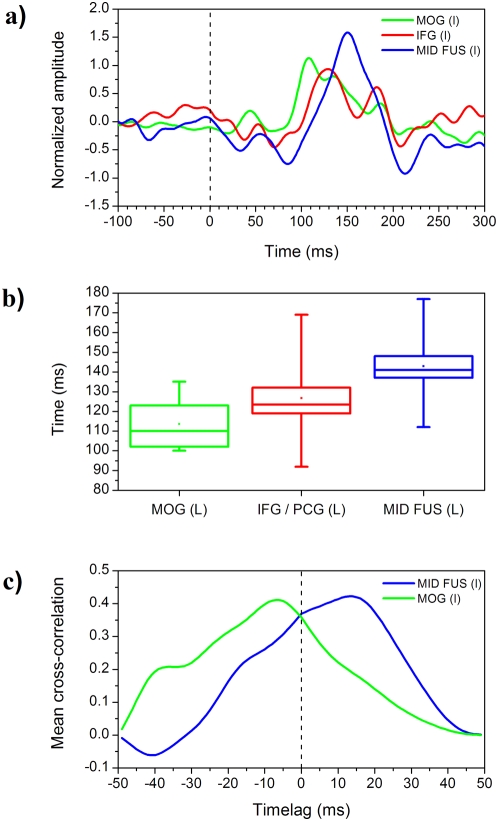
Normalised ERFs, peak latency, and mean cross-correlation.(A) Shows the normalised ERFs for centrally presented words in the left MOG (green), left IFG (red), and left MID FUS (VWFA) in blue. (B) Shows box and whisker plots for the mean peak latency in the same ROIs. (C) Shows the mean cross-correlation between IFG and left MID FUS (VWFA) in blue and IFG and left MOG (green).